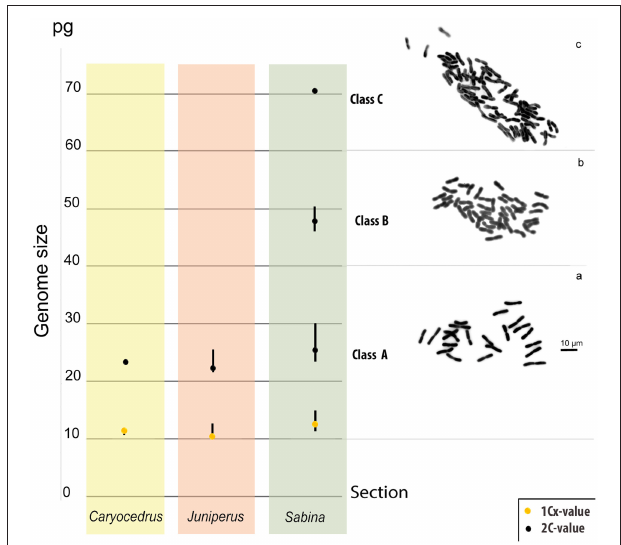
FIGURE 1 | Genome size (2C-values, represented by black dots) classes in Juniperus and their unequivocal relationship with the chromosome number. Class A represents the range of genome sizes for all diploid species confirmed by published chromosome numbers. Class B represents the range of genome sizes for all tetraploid species confirmed by published chromosome number. Class C represents the genome size of the only hexaploid species so far reported (i.e., J. foetidissima ). (A) Chromosomes of the diploid J. excelsa (our data); (B) chromosomes of the tetraploid J. thurifera (reproduced from Vallès et al., 2015), and (C) Chromosomes of J. foetidissima confirming its hexaploid status (our data). Monoploid genome size (1C x -values, represented by yellow dots) of the three sections were also